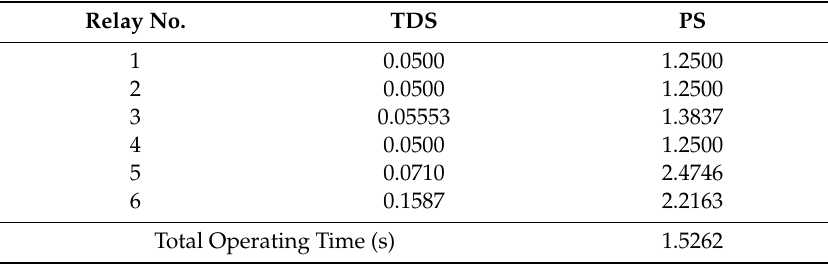
Table 2. Optimal TDS for the IEEE three-bus system.